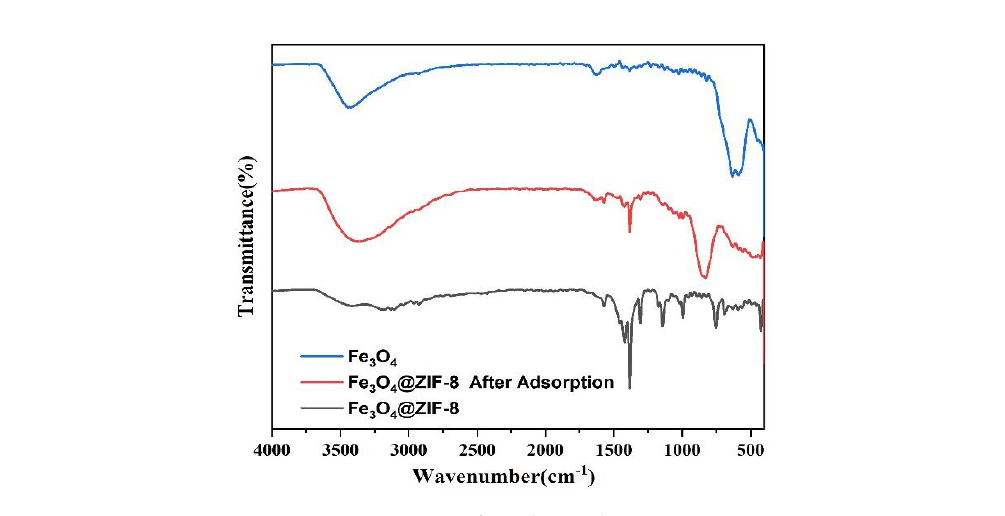
3 O 4 , Fe 3 O 4 @ZIF-8.